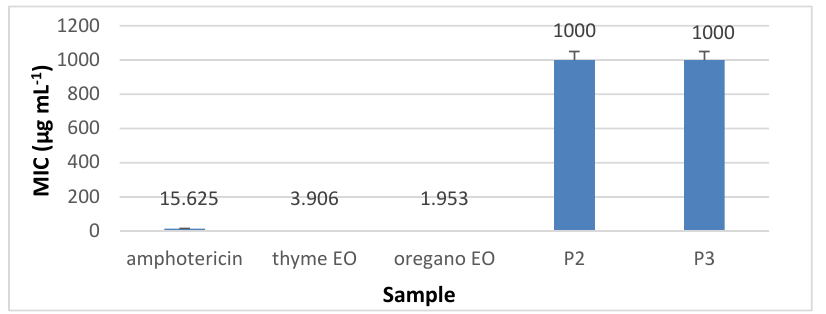
Figure 13. MIC of collagen nanofibres loaded with essential oils against C. albicans ATCC 10231, as compared to amphotericin and essential oils.